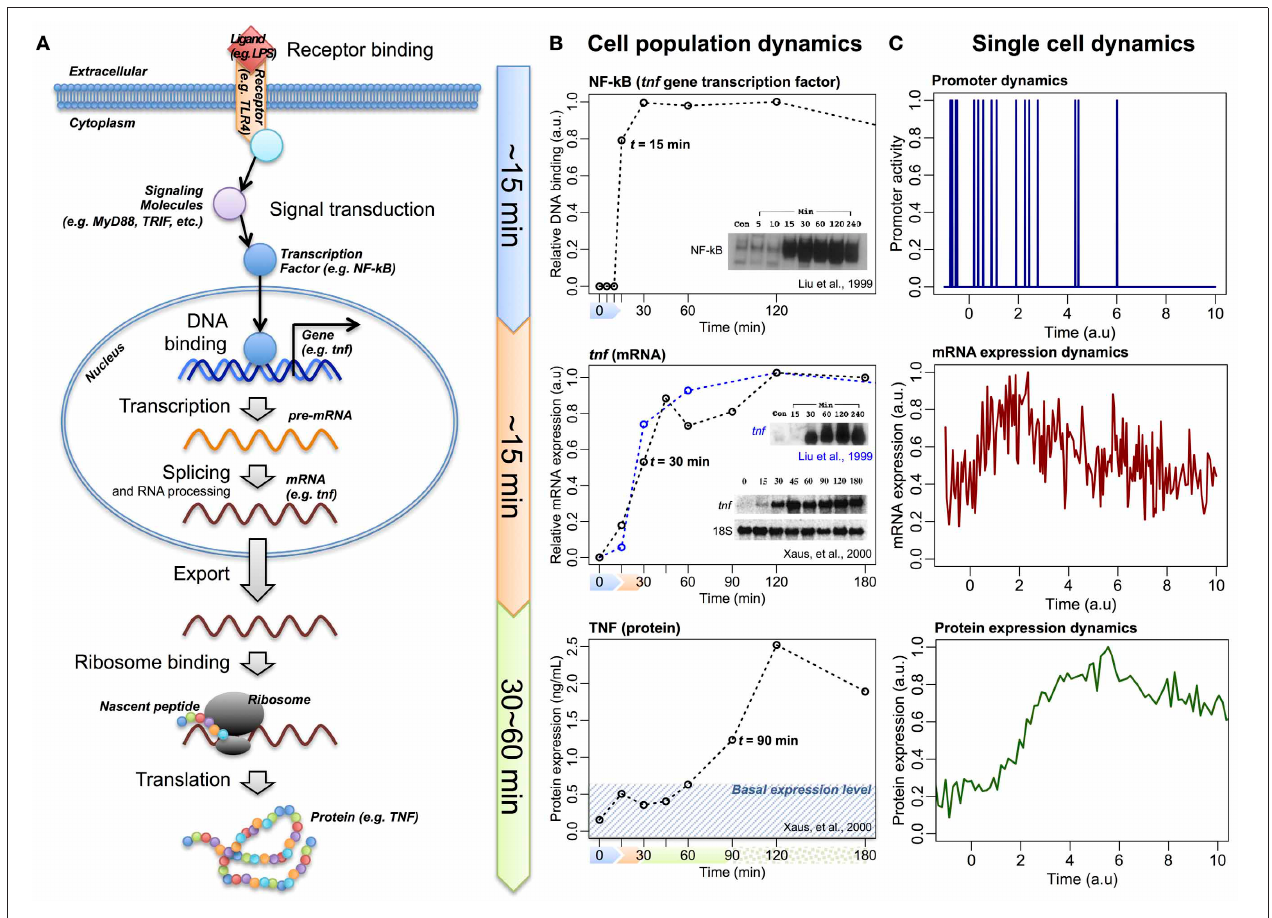
FIGURE 3 | The information flow of central dogma. (A) Schematic of LPS/TLR4-induced TNF expression, via transcription factor NF- κ B and tnf gene, following linear information flow. (B) Experimental temporal profiles of promoter binding activity of NF- κ B (upper panels), tnf